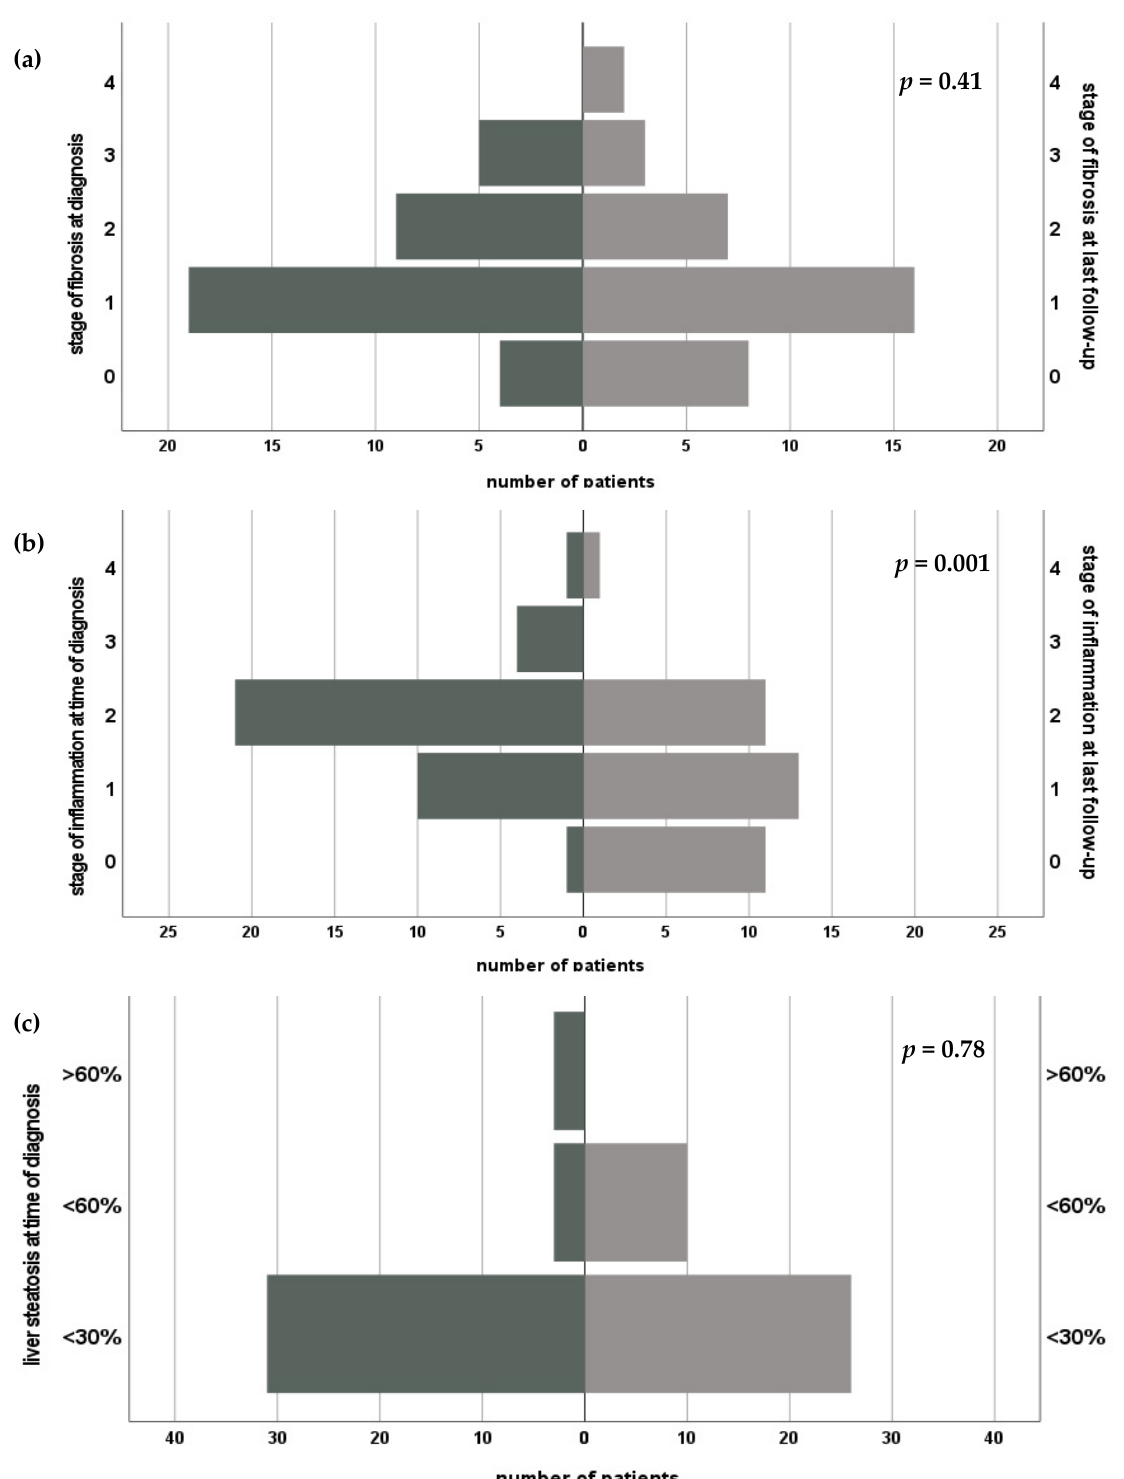
Figure 3. Course of fibrosis ( a ), inflammation grade ( b ) and steatosis hepatis ( c ) after diagnosis of de novo HBV after liver transplantation.